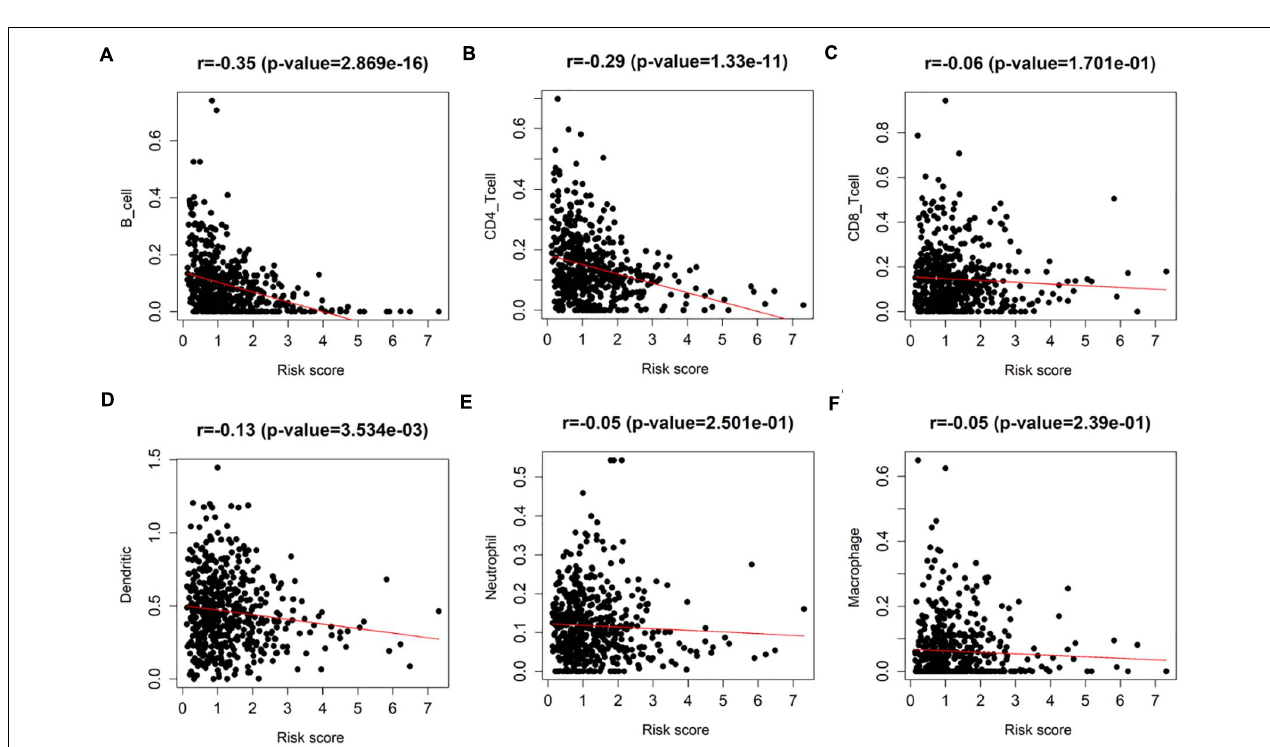
FIGURE 6 | Examination of the independence of the risk score predicted by the prognostic model. (A) Univariate COX regression analysis was conducted on clinical traits (age, gender, T stage, N stage, and clinical stage) and the risk score. The forest plot shows HR and p -value of each prognostic factor. (B) Multivariate COX regression analysis was performed on clinical traits and the risk score. (C) ROC curves and AUCs of 3-year survival of each prognostic factor.